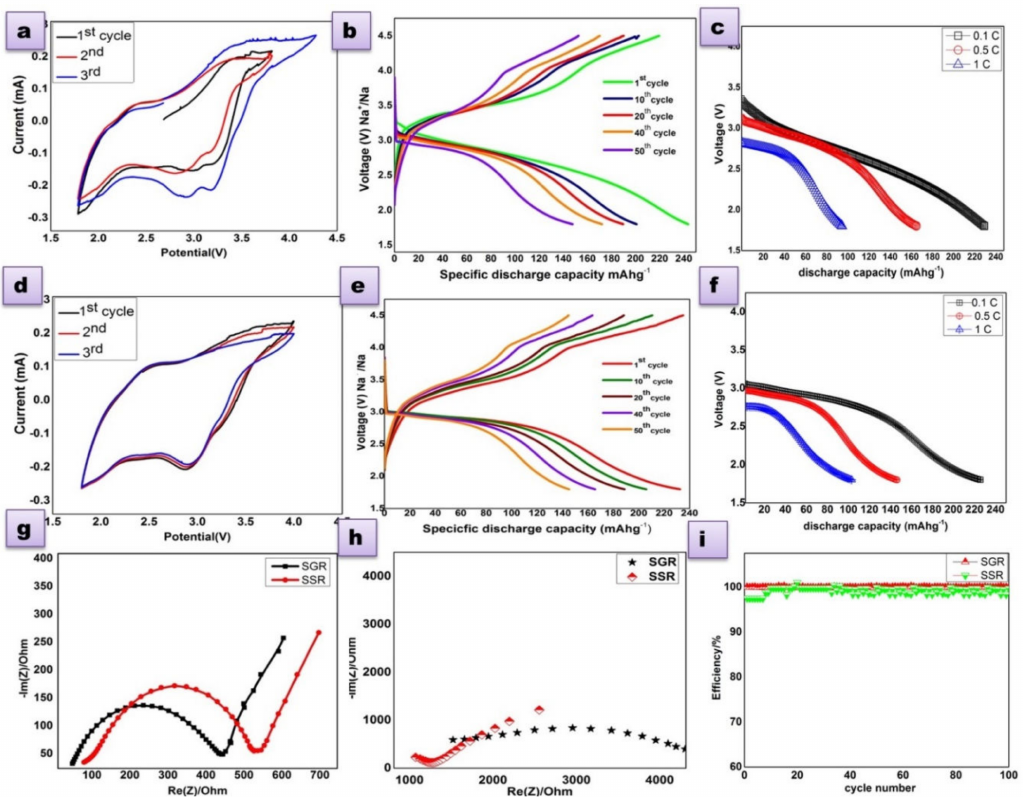
Figure 3. ( a ) Cyclic voltammetry of sample P2-Na 2 / 3 Ni 1 / 3 Mn 2 / 3 O 2 prepared via the SSR